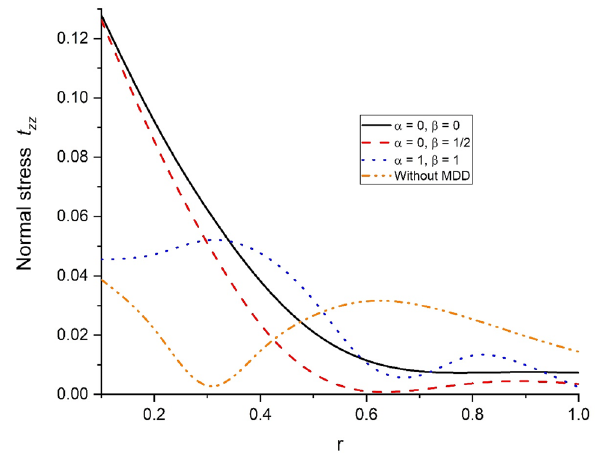
Fig. 3 Variations of conductive temperature 𝜑 w.r.t. radius r